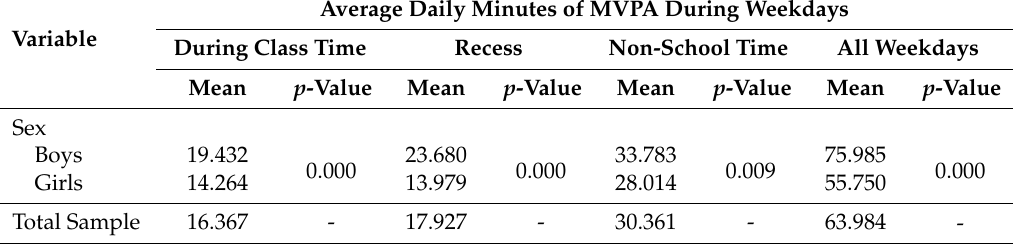
Table 3. Descriptive statistics for average daily minutes of MVPA by gender ( n =